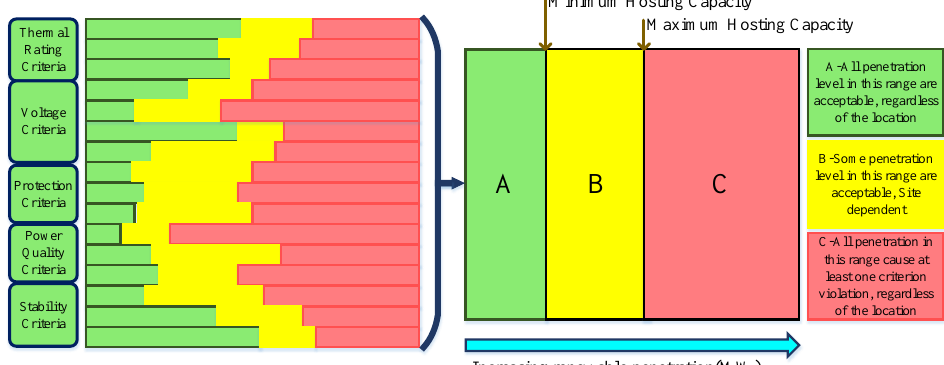
Figure 1. Different regions of the HC in a